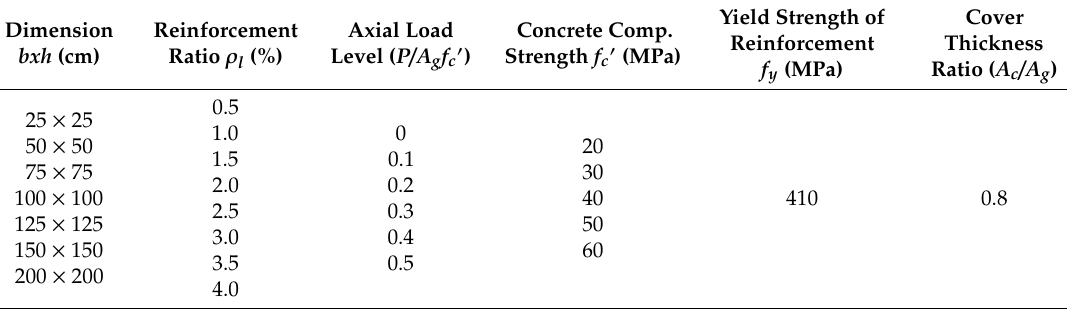
Figure 3. Reinforced concrete column cross-sections. 142 Table 1. Summary of column models considered in the analyses. 143